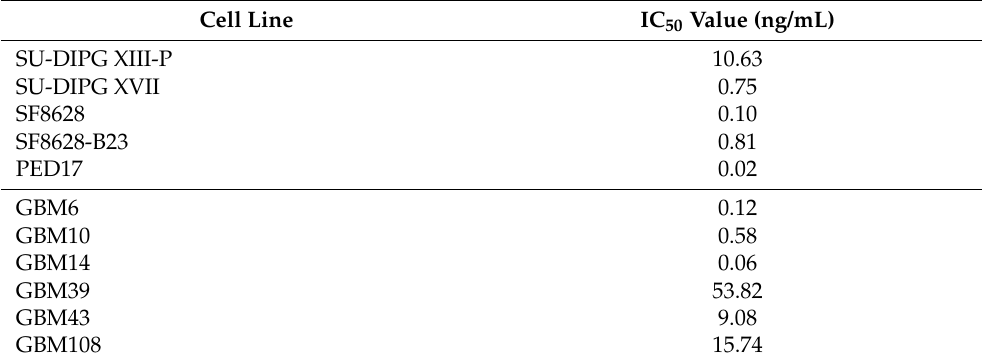
Table 1. Fifty % inhibitory concentration (IC 50 ) values of GB-13. Cell Line IC 50 Value